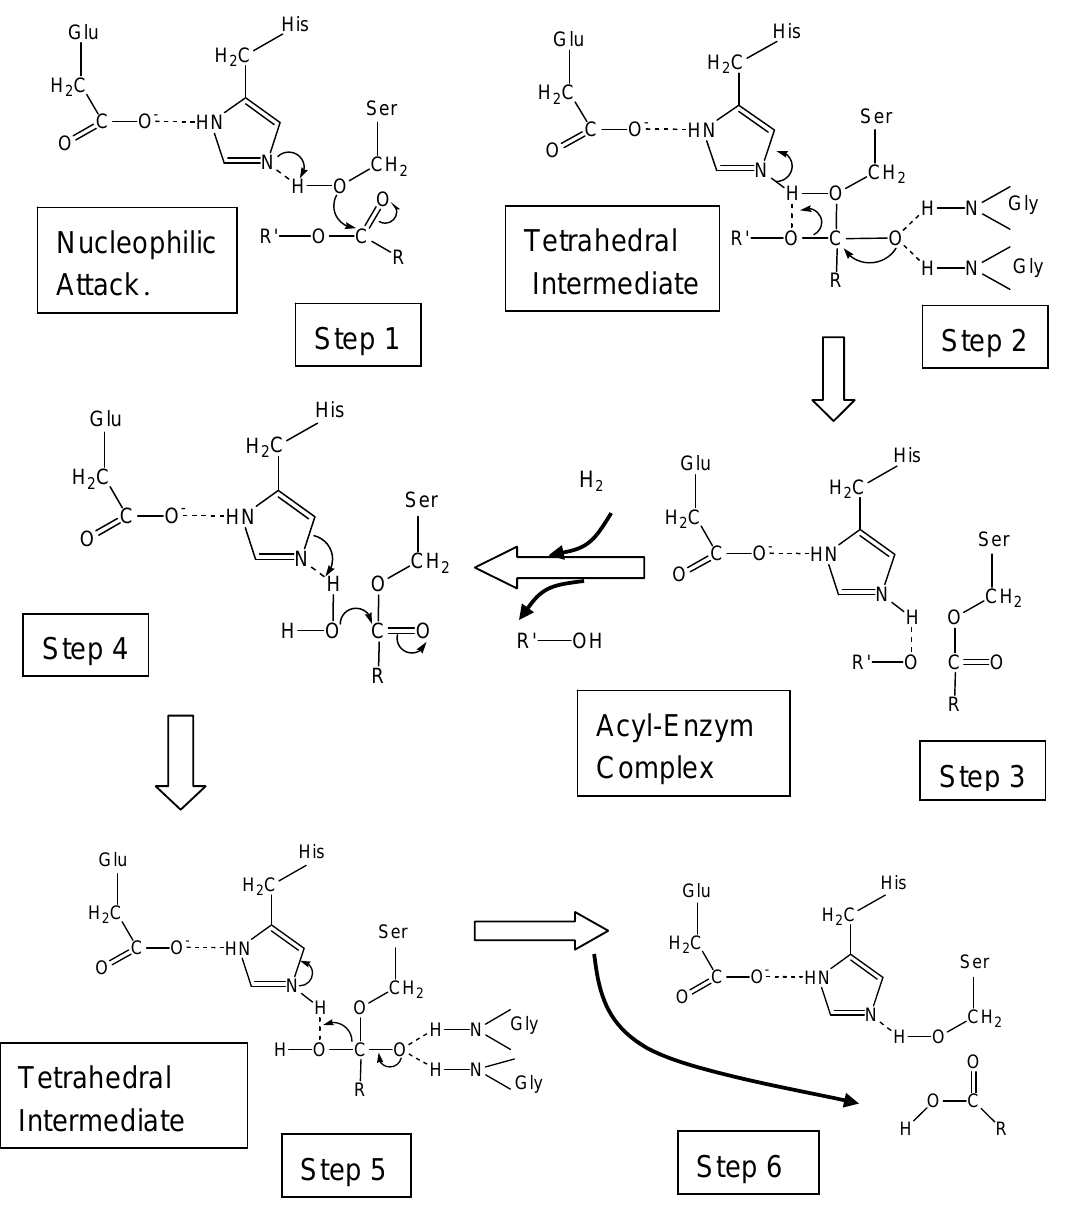
Figure 3 . Proposed mechanism for the action of CES. Conformation of the Ser-His-Glu catalytic triad in